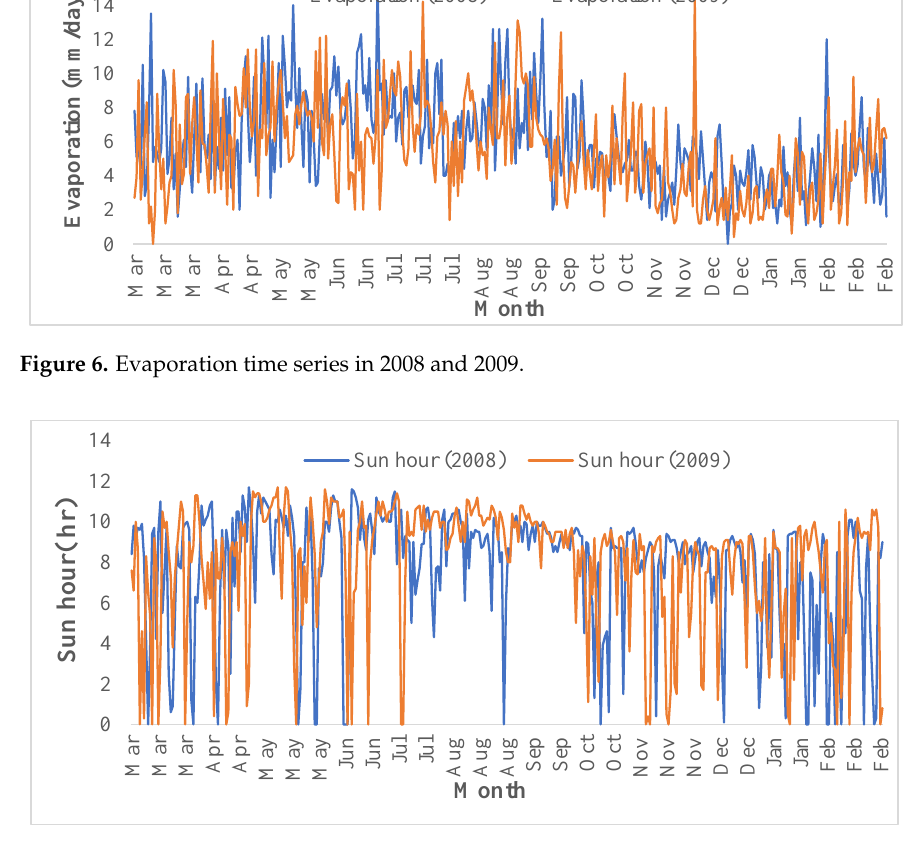
Figure 7. Time series of sunny hours in 2008 and 2009.